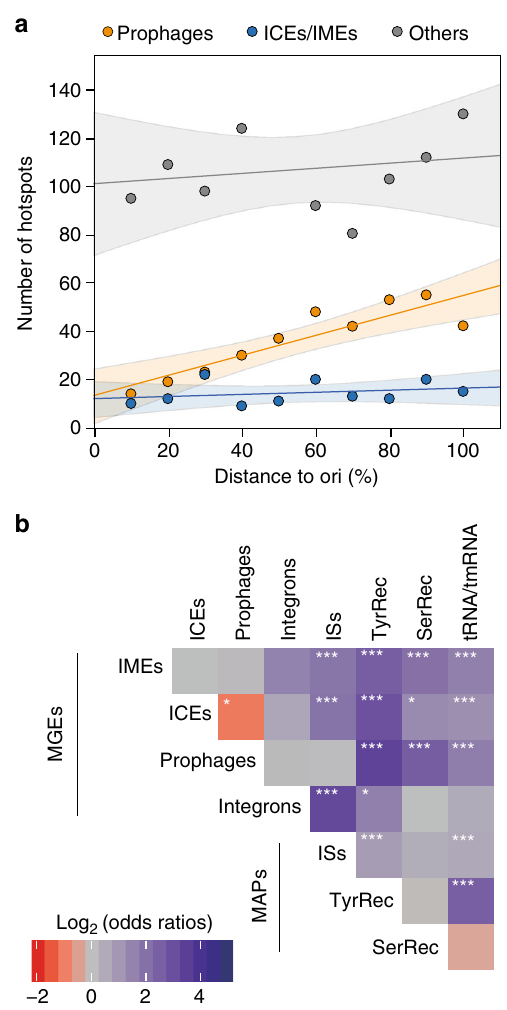
Fig. 6 Chromosomal context of hotspots. a Number of hotspots containing prophages, ICEs/IMEs, and none of the above along the origin – terminus axis of replication. Linear regression and the con fi dence limits ( shaded area ) for the expected value (mean) were indicated for each category. The number of hotspots including prophages increases linearly with the distance to the origin of replication (Spearman ’ s ρ = 0.87, P < 10 − 3 ), but this is not the case for the other two categories (both P > 0.05). b Heatmap of odds ratios of co-localizations in hotspots of MGEs, mobility-associated proteins (MAPs) and RNAs. *** P < 10 − 3 ; ** P < 10 − 2 ; * P < 0.05; Fisher ’